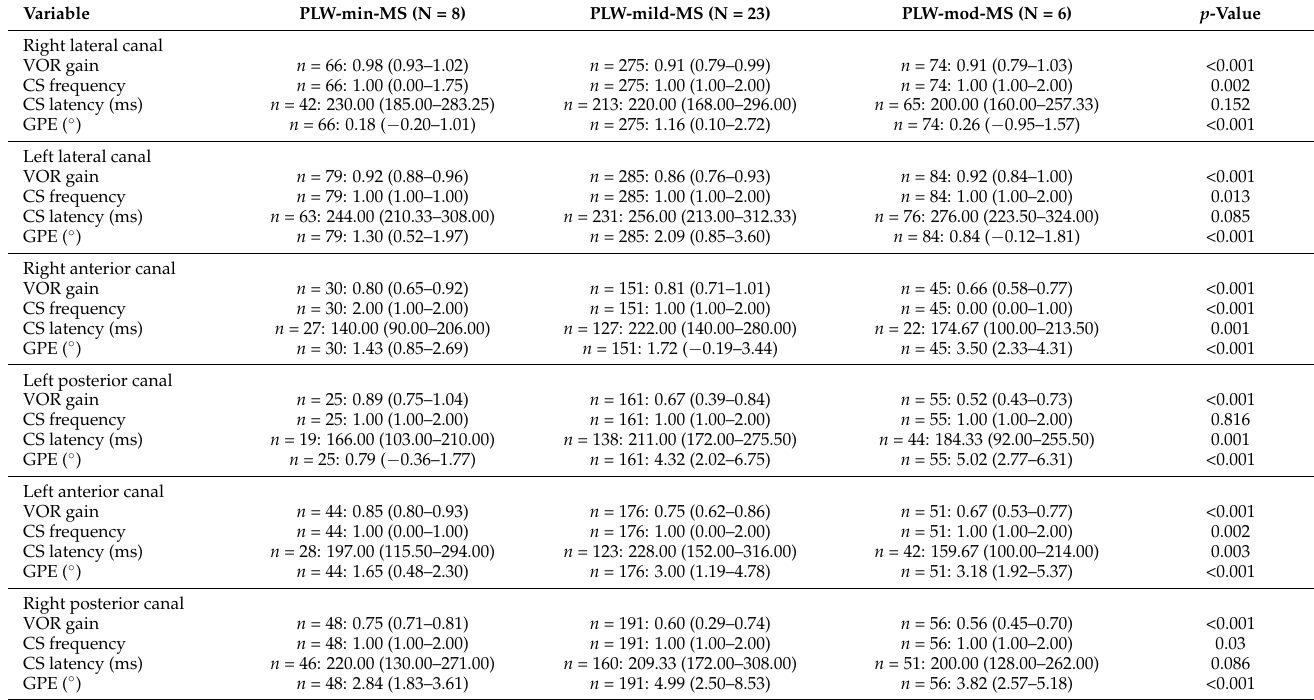
Table 2. Between-group Differences in VOR Gain, CS Frequency, CS Latency, and